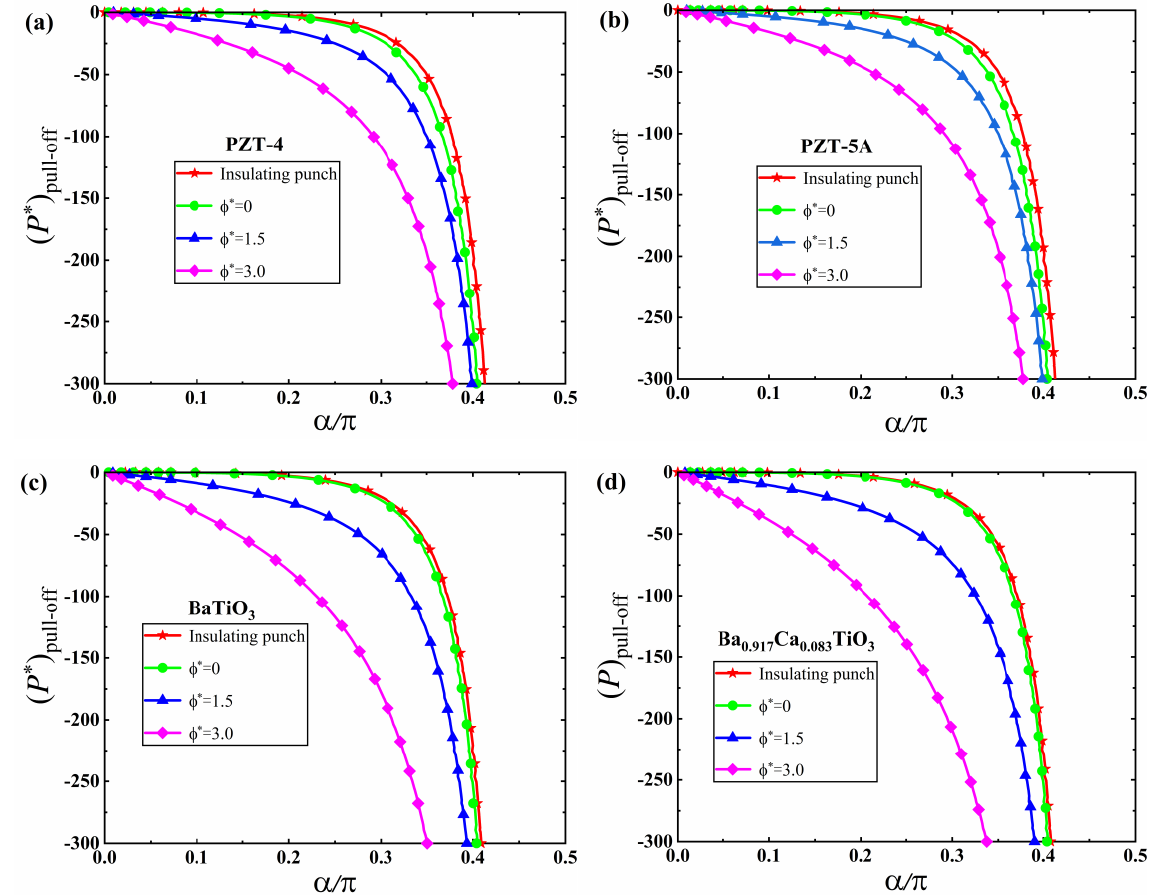
P pull-off , with the dimensionless electric / 3 = . ( a ) PZT-4. ( b ) PZT-5A. ( c ) BaTiO 3 . ( d )